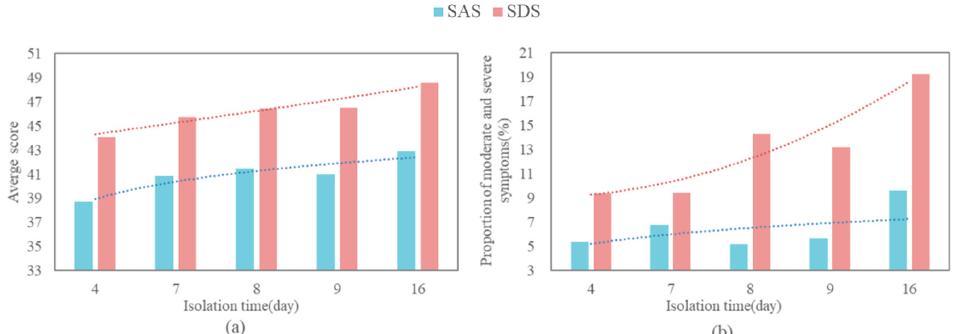
Figure 14. Isolation time differences in ( a ) the mean SAS and SDS scores and ( b ) the proportion of moderate and severe symptoms.